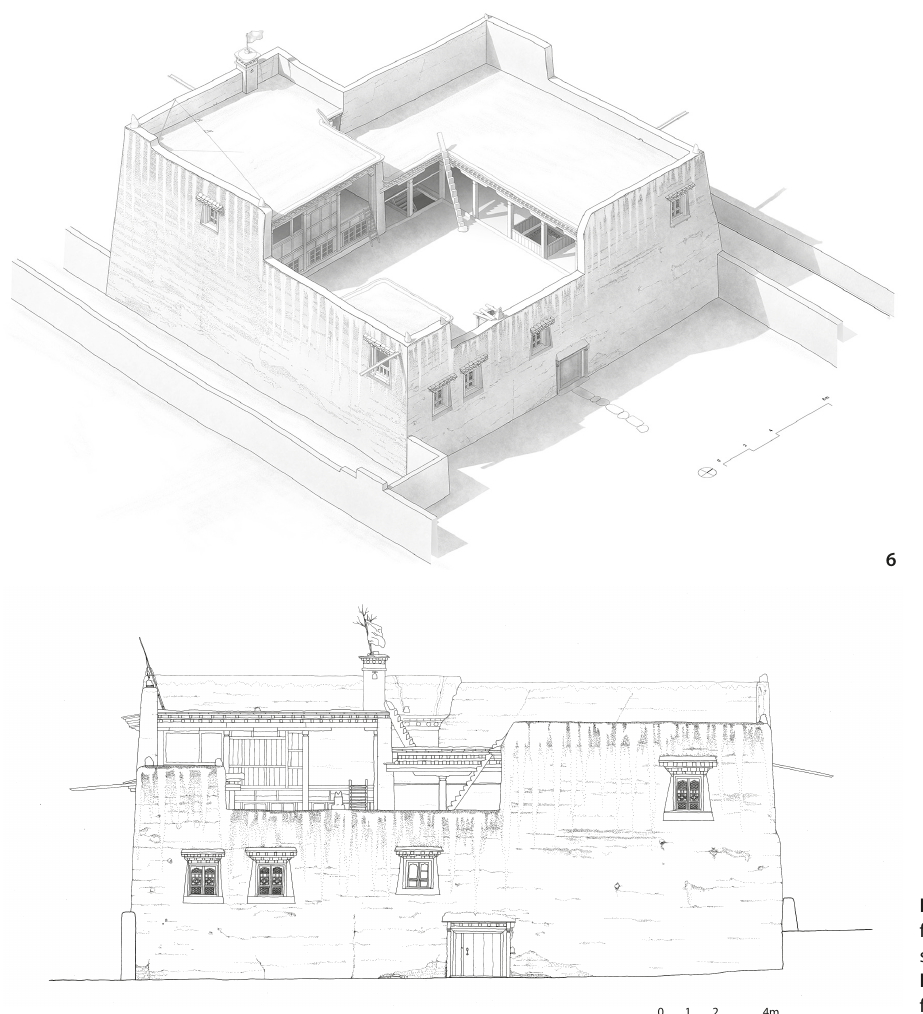
Figure 6 Isometric view of the farmhouse in Chatreng from the southeast (Source: the authors). Figure 7 East elevation of the farmhouse in Chatreng (Source: the authors).